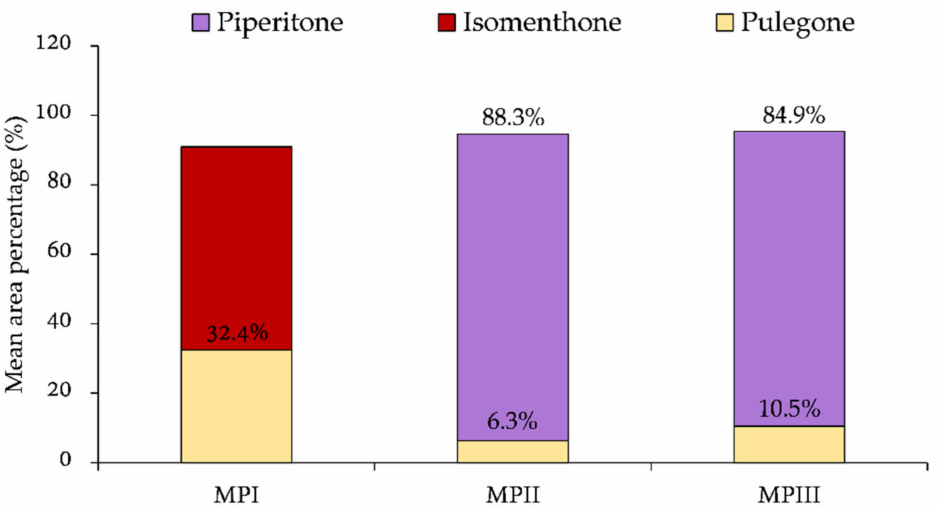
Figure 5. Chemotypes identified in M. pulegium plants collected in the three Sicilian sampling areas (I, II, and III). Percentage values reported in the graph bar refer to the average content of pulegone, isomenthone, and piperitone found in both EOs from leaves and flowers from each sampling point (see Section 3.2 for more